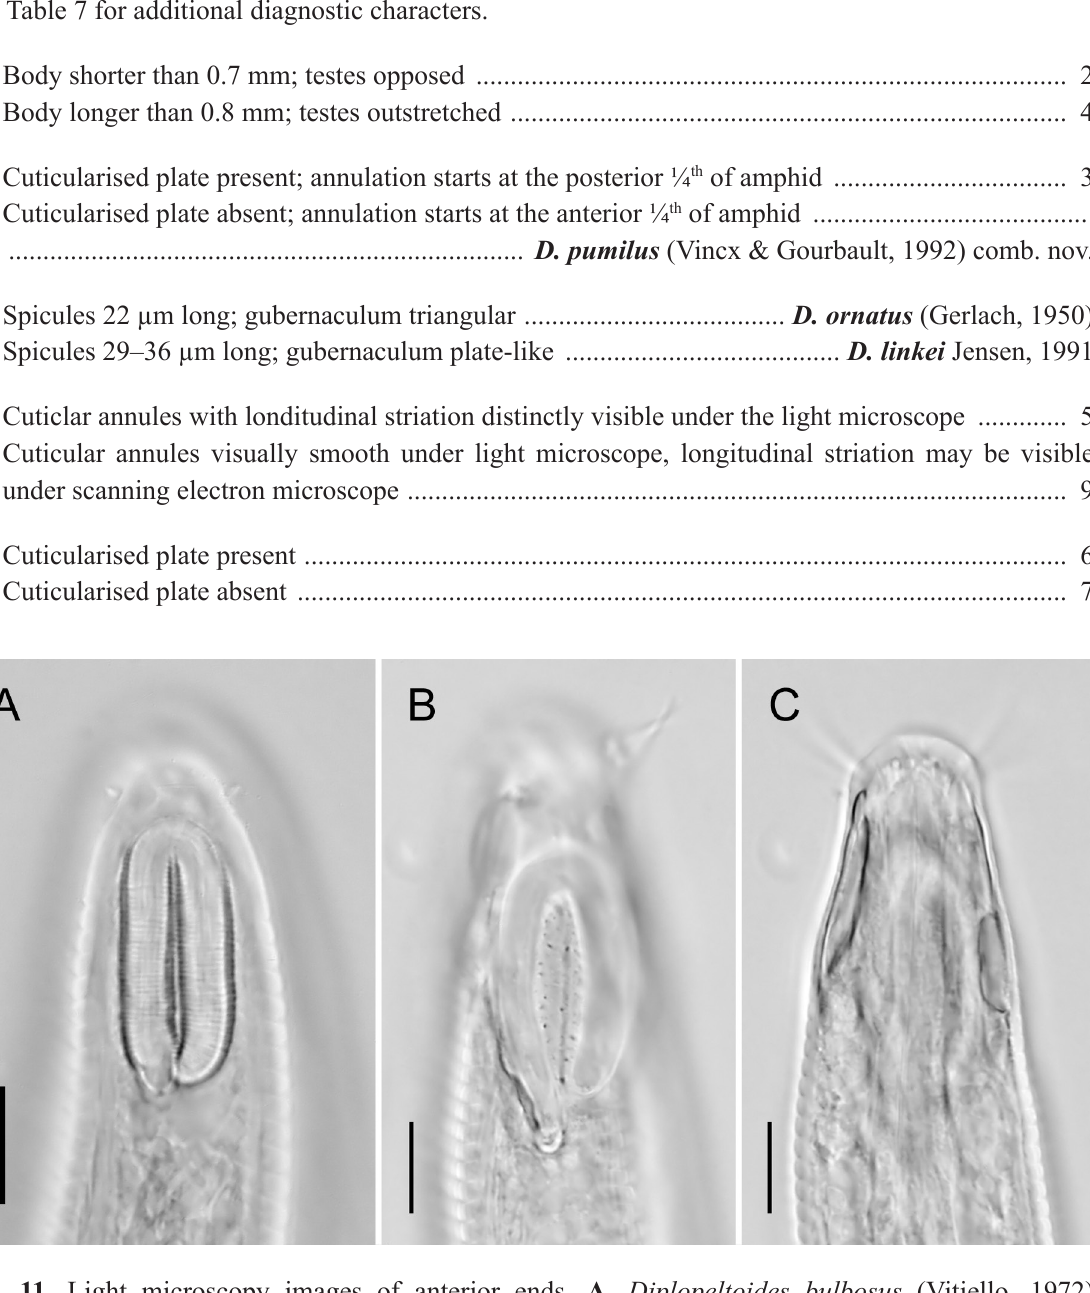
Fig. 11. Light microscopy images of anterior ends. A . Diplopeltoides bulbosus (Vitiello, 1972) comb. nov., female, amphid. — B–C . Diplopeltoides grandis sp. nov., holotype, female. B . Amphid. C . Cuticularised plate. Scale bars: A–C = 20